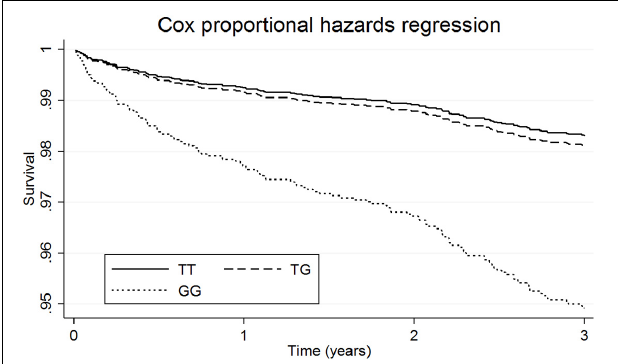
FIGURE 2 | Survival functions of atrial fibrillation in patients on L-thyroxine by genetic variation at INSR - rs4804416 within 3 years of follow-up.